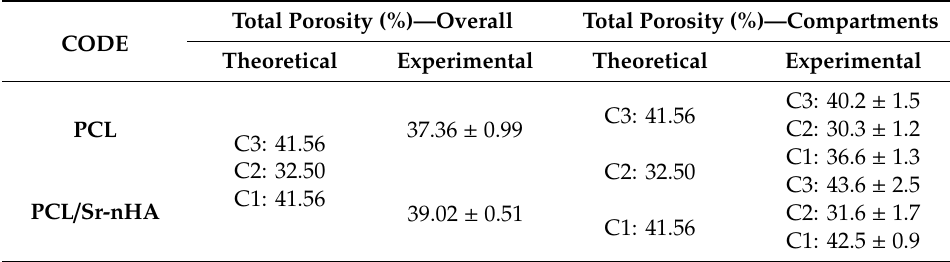
Table 3. Theoretical and experimental porosity values of the overall 3D sca ff olds (PCL and PCL / Sr-nHA) and for each compartment (C1, C2 and C3) within the overall